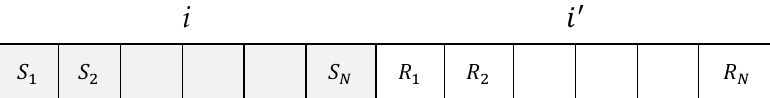
Figure 7. The position scheme used by whales.